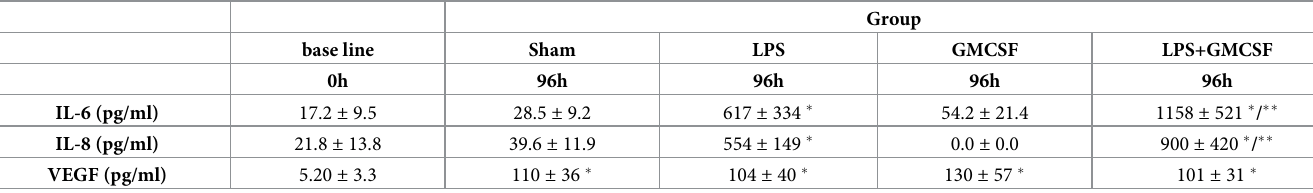
Table 3. Serum concentrations of proinflammatory